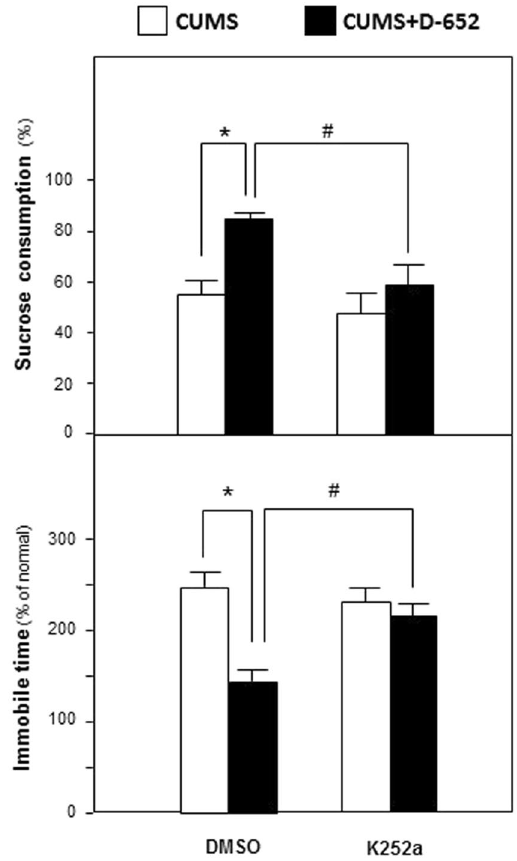
Figure 8. The blocker of Trk attenuates antidepressant actions of KXS in the behavioral tests of CUMS-treated mice. At the end of CUMS exposures, one group of the mice were treated simultaneously with D-652 and K252a for 7 days. D-652 was orally treated and K252a (dissolved in DMSO) was administered intraperitoneally. Then, sucrose preference test and forced swimming test were carried out. The CUMS mice only injected with DMSO and treated with combination of DMSO and D-652 were applied for contrast. Comparisons between groups were carried out by a two-way ANOVA followed by a post-hoc Bonferroni test. Values are expressed in the percentage of non-stressed control group as Mean ± SEM (n = 8). # p < 0.05, ## p < 0.01 (comparison between group treated with CUMS/DMSO plus D-652 and group treated with CUMS/DMSO plus D-652 and K252a). * p < 0.05, ** p < 0.01 (comparison between group treated with CUMS/DMSO and group treated with CUMS/ DMSO plus